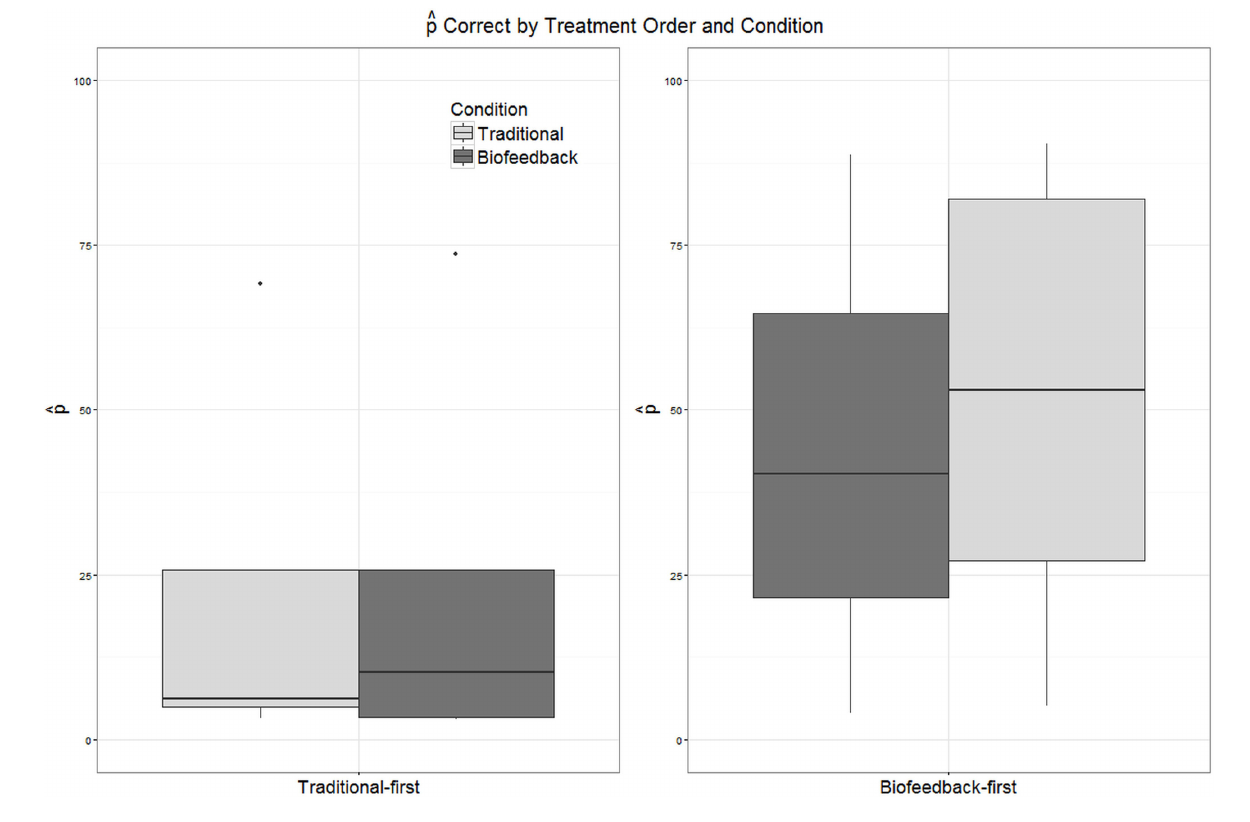
FIGURE 7 | Boxplots depicting the distribution of values of ˆ p correct in pre- and post-treatment probes administered during biofeedback versus traditional treatment. Participants have been partitioned into two groups reflecting the order in which treatment was delivered (traditional-first versus